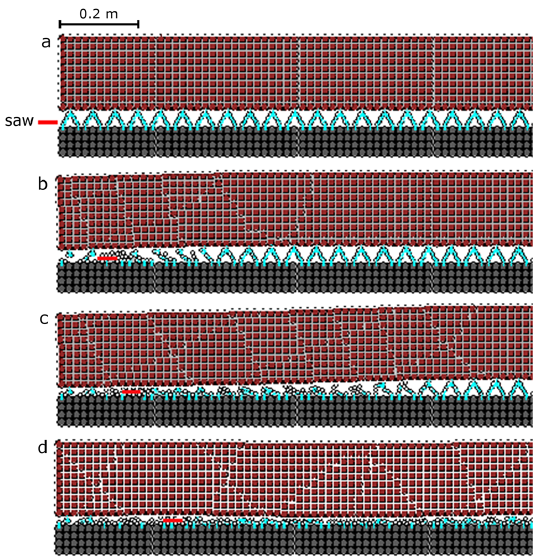
Figure 7. Snapshots of a PST numerical experiment. (a) Initial sys- tem t = 0 . 1s, (b) onset of crack propagation t = 0 . 26s, (c) dynamic propagation t = 0 . 28s; (d) complete failure of the WL t = 0 . 45s.